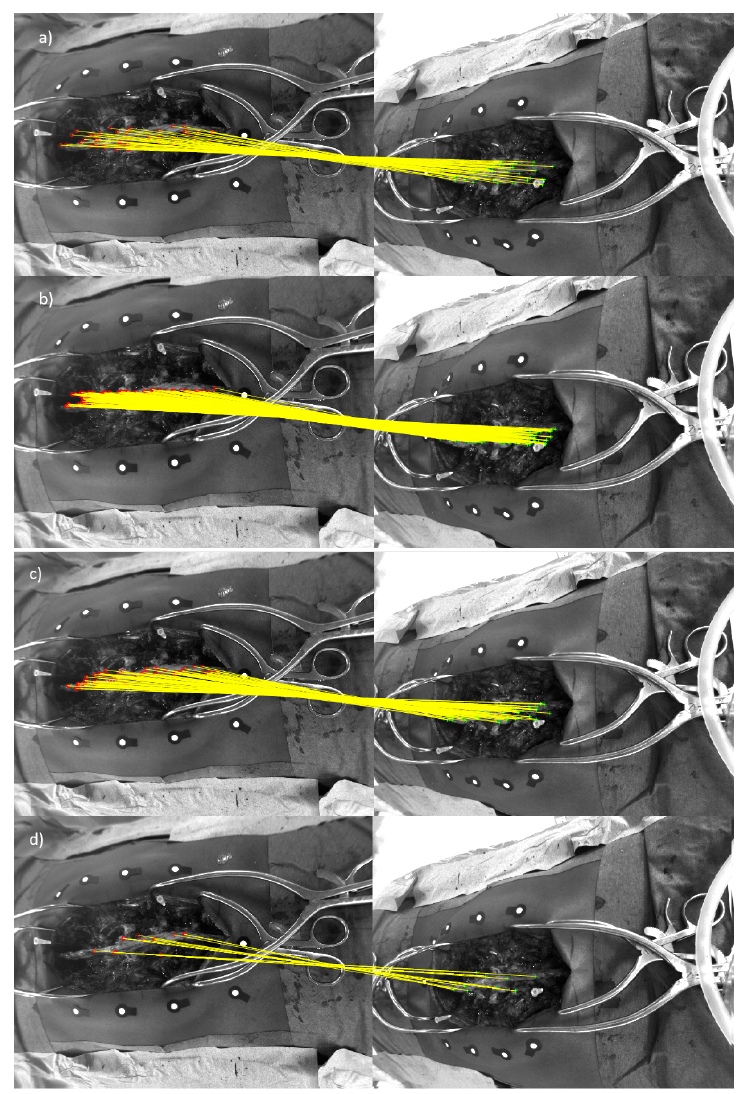
Figure 10. ( a ) FAST-based feature matching of the spine for two image views for Patient 15. ( b ) ORB-based feature matching of the spine for two image views for Patient 15. ( c ) SURF-based feature matching of the spine for two image views for Patient 15. ( d ) MSER-based feature matching of the spine for two image views for Patient